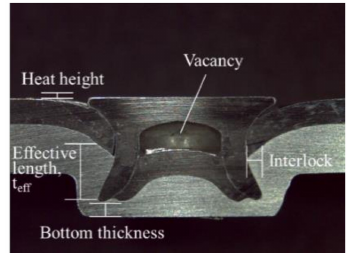
Figure 3. Dimensions of specimen.